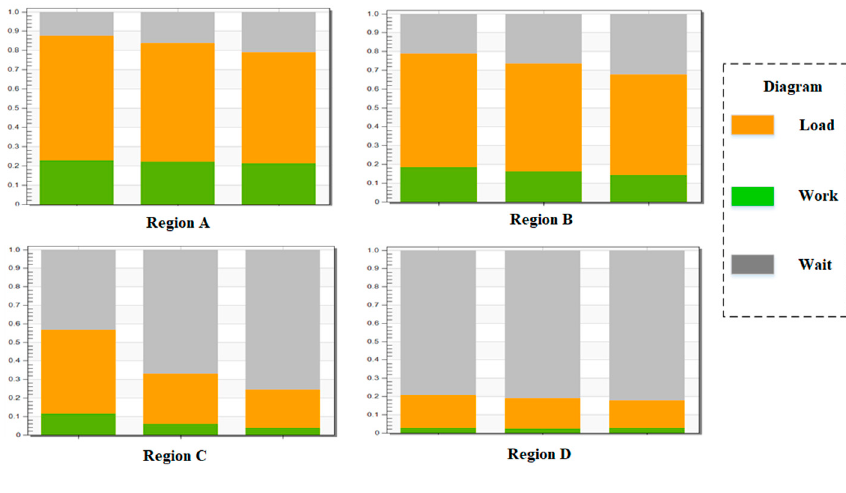
Figure 13. Utilization comparison ratio.